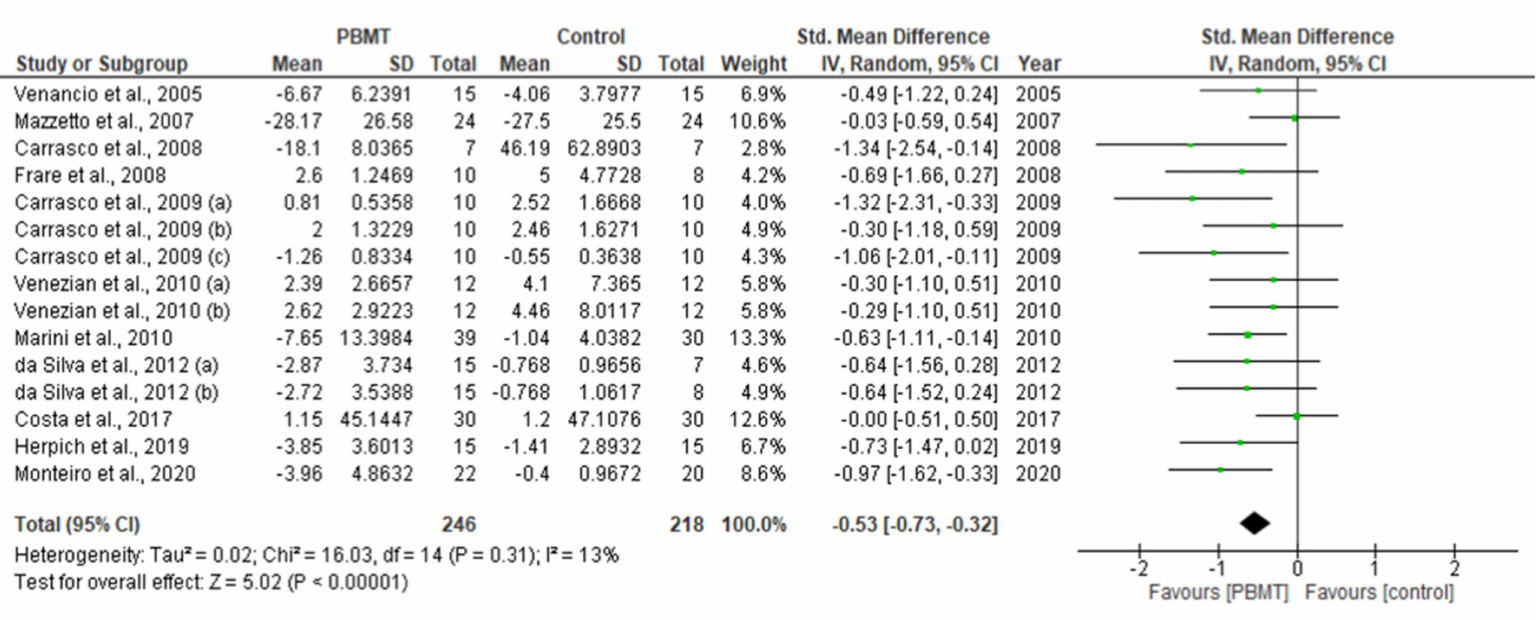
Figure 9. Sensitivity analysis for primary outcome qualitative pain reduction assessment (VAS score) from baseline up to the final follow-up